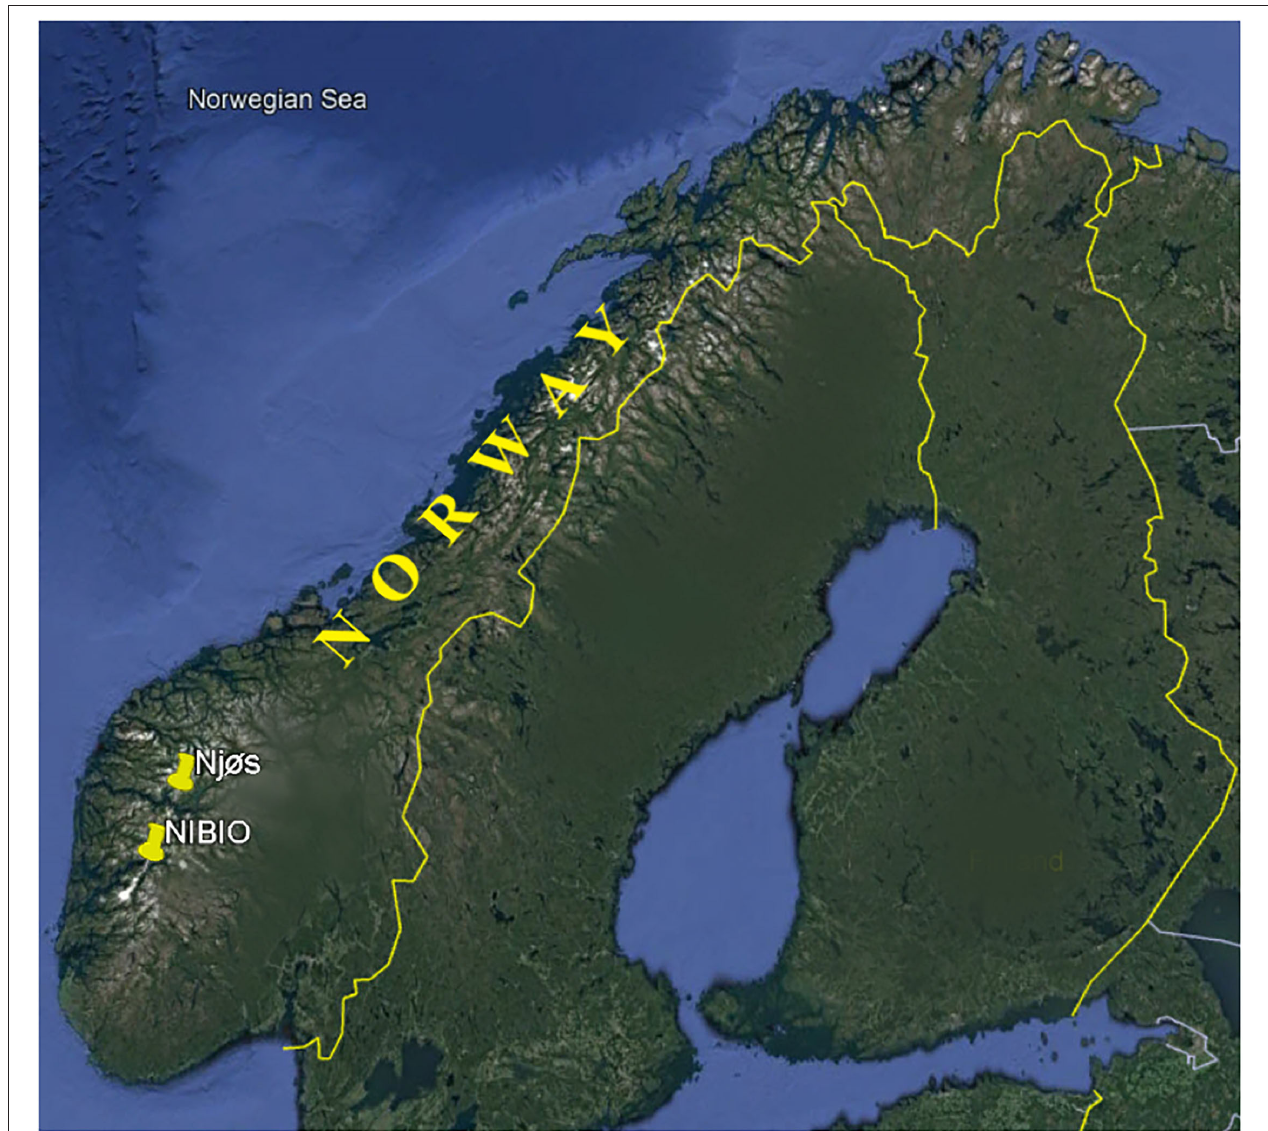
FIGURE 1 | Sampling sites of apple fruits in Norway. NIBIO, Norwegian Institute of Bioeconomy Research, Ullensvang area, and